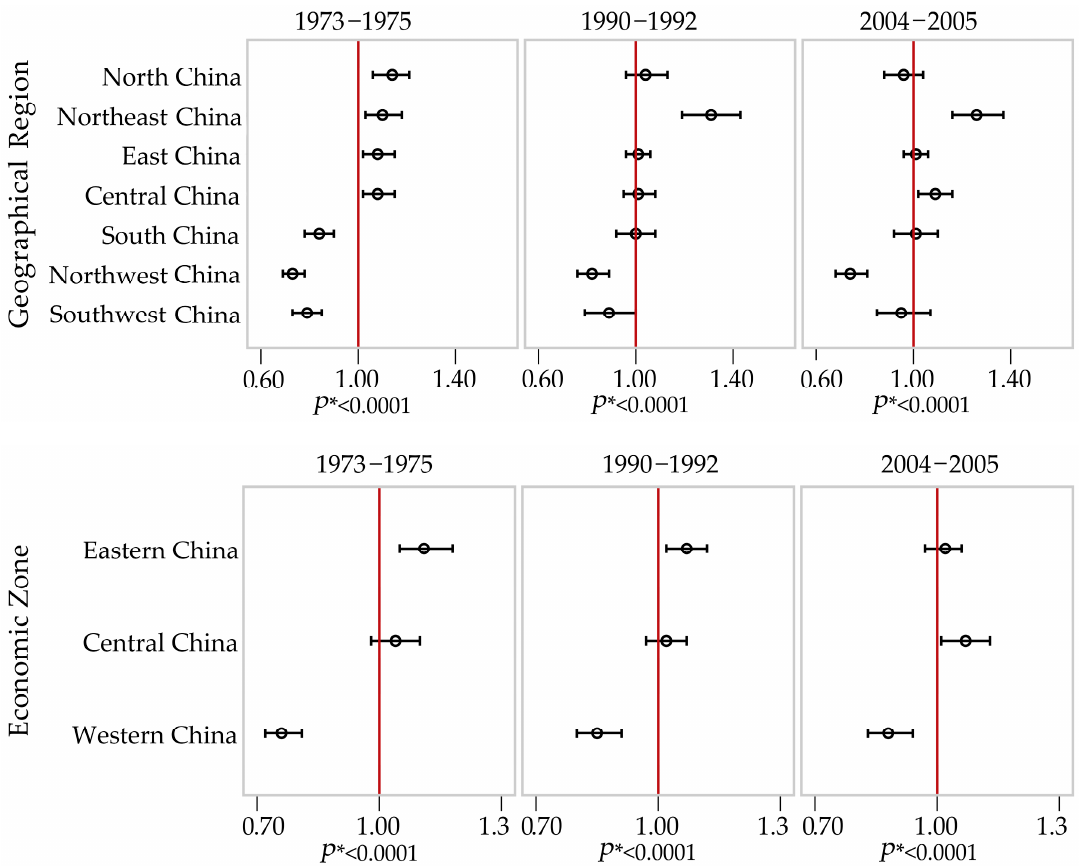
Figure 3. Rate ratios (RR) and 95% confidence intervals for female breast cancer mortality in China by geographical region and economic zone across three time periods, 1973–1975, 1990–1992 and 2004–2005, with the national average being the reference (1.00). * p -value for the effect of geographical unit.